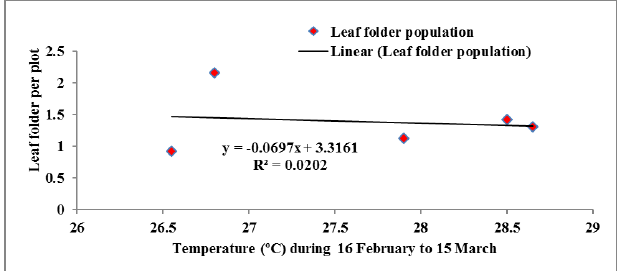
Figure 1: Relationship between the population of leaf folder and temperature There was a negative correlation (R 2 = -0.175) between the population of leaf folder and relative humidity. It indicates that the population of leaf folder was decreased with increasing relative humidity. A